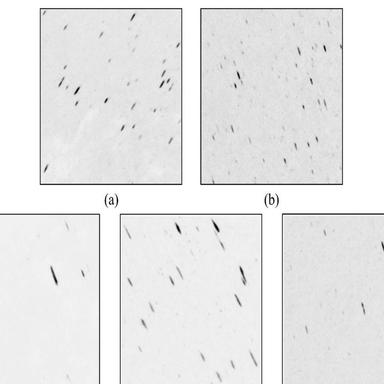
Dark-field micrographs of dislocation loops after 150 dpa, dual ion irradiation: stainless steels (a) 316L and (b) 310; precipitate-strengthened, Ni-base alloys (c) X750, (d) 718, and (e) 725; and solid solution, Ni-base alloys (f) 690, (g) 625, and (h) C22. Micrographs were captured using rel-rod imaging, with intensity values inverted to improve the visibility of small defects.